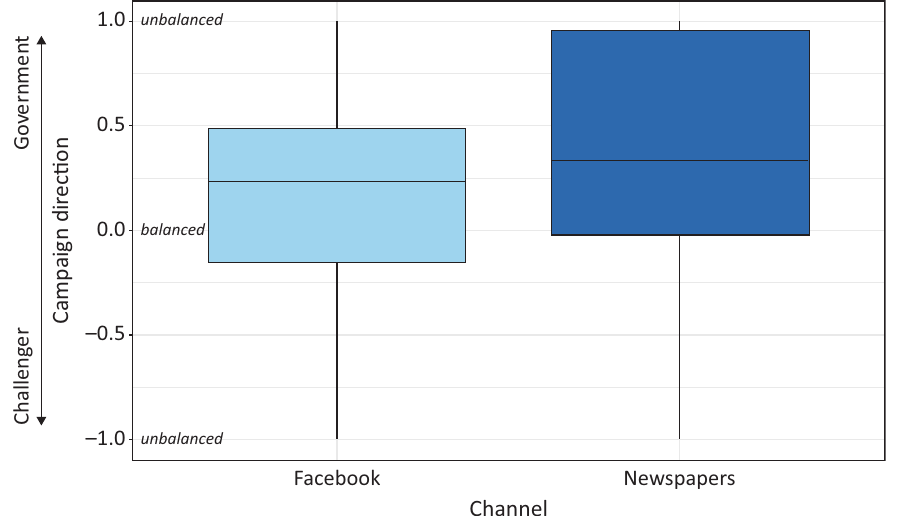
Figure 4. Difference between the government camp and the challenger camp (campaign direction) in terms of Facebook posts and newspaper advertisements from